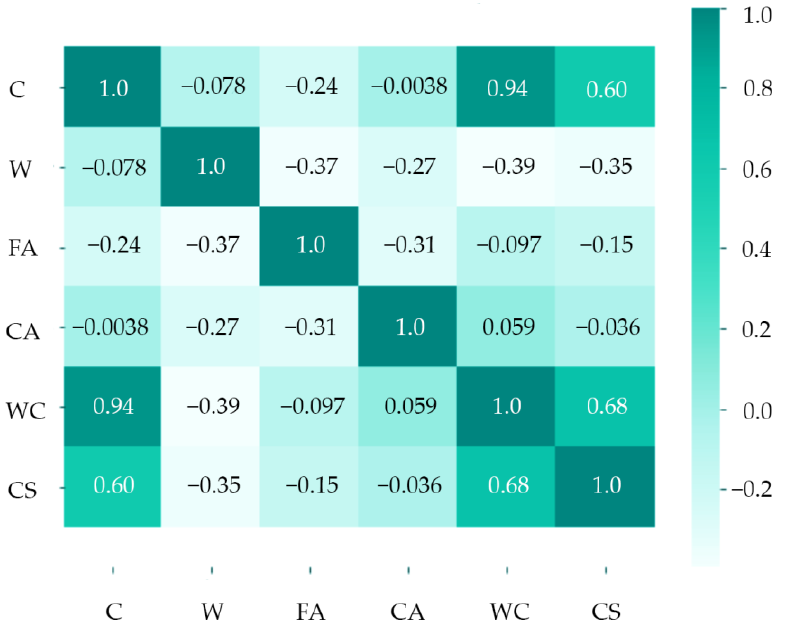
Figure 3. Feature correlation heatmap.